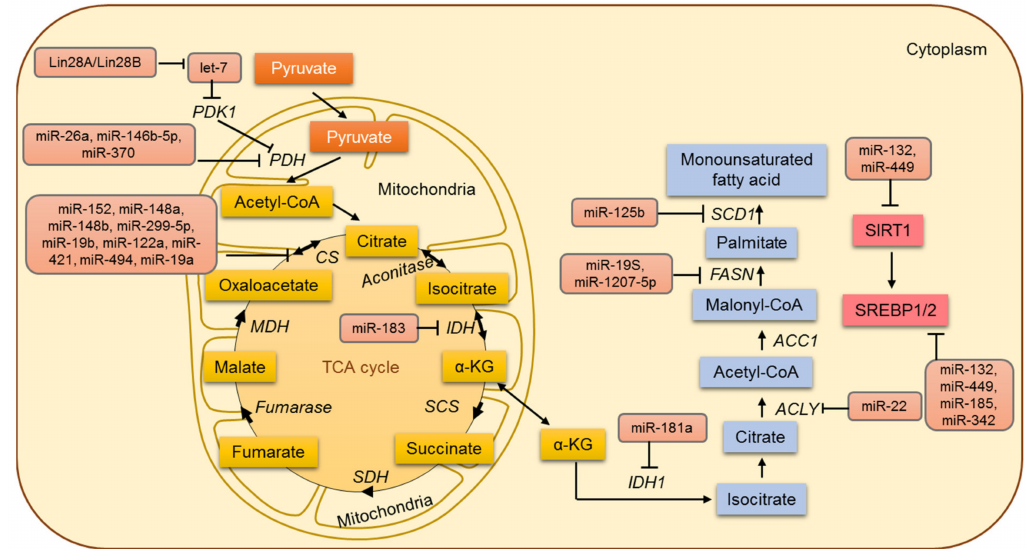
Figure 4. The miRNA-based regulation of lipid and mitochondrial metabolism in cancer